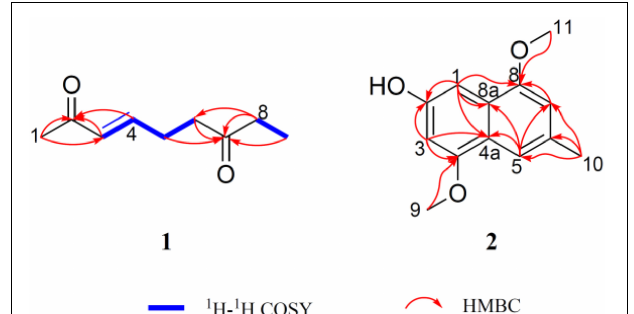
FIGURE 5 | Key 1 H- 1 H COSY and HMBC correlations of peperodione (1) and peperophthalene (2) .